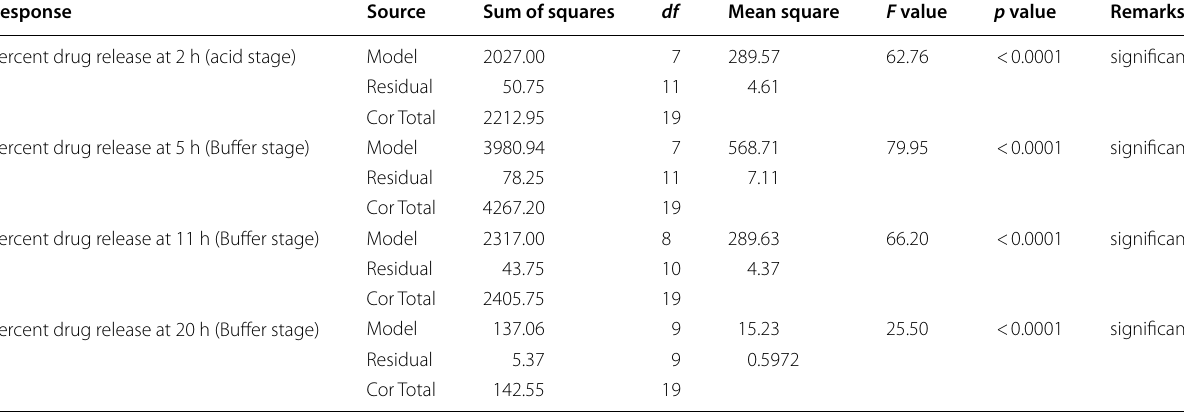
df degrees of freedom, Cor Total Corrected total sum of squares; α : 0.05